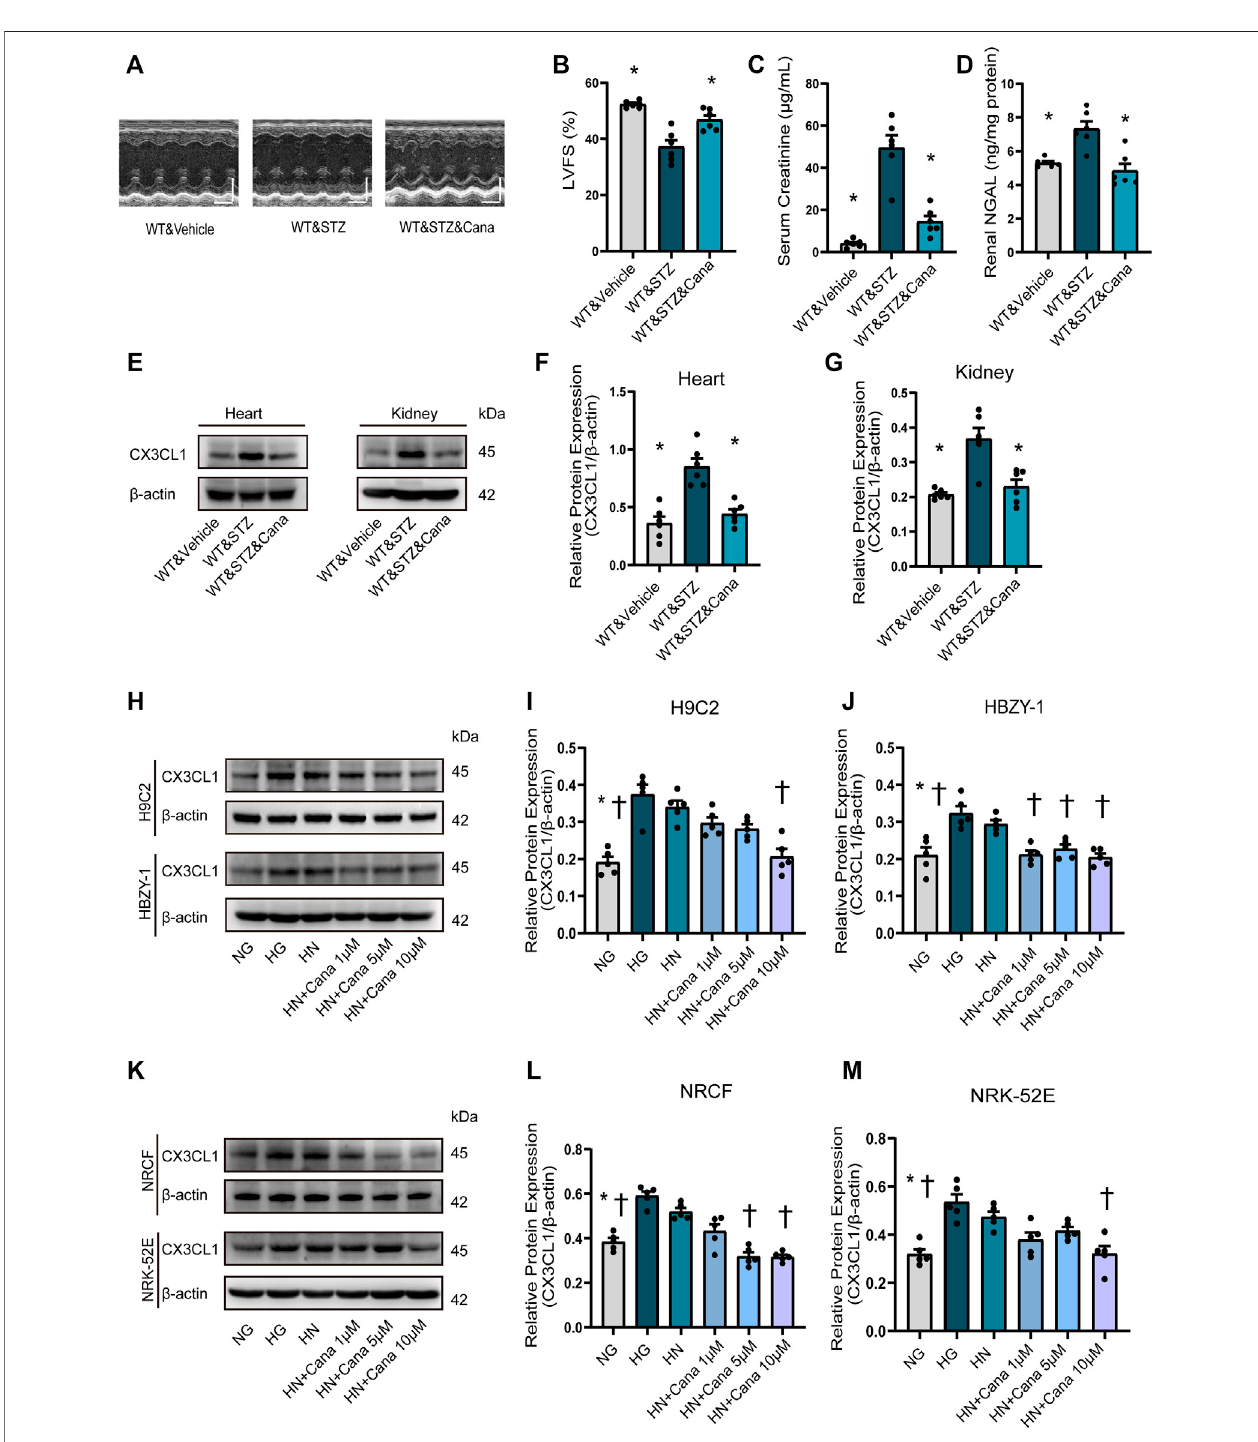
FIGURE 7 | Canagli fl ozin (Cana) improved cardiorenal dysfunction and repressed diabetic induced or high glucose induced CX3CL1 expression. (A) M-mode of echocardiography. Scale bars, 2 mm (upper panels), horizontal bars represent 100 ms. (B) Left ventricular fractional shortening (LVFS). (C) Serum creatinine concentration. (D) Renalneutrophilgelatinase-associatedlipocalin(NGAL)content. (E) CX3CL1expressiondetectedbyWesternblottinginheartandkidneytissues. (F) Semi-quantitation of CX3CL1 expression in heart. (G) Semi-quantitation of CX3CL1 expression in kidney. * p < 0.05 vs . WT&STZ mice; n = 6 per group. (H – M) Western blotting of CX3CL1 levels in cultured cardiomyocytes (H9C2), glomerular mesangial cells (HBZY-1), neonatal rat cardiac fi broblasts (NRCF) and renal tubular epithelial cells (NRK-52E). The cultured cells were exposed for 5 days either to normal concentration of glucose (5 mM, NG) or high concentration of glucose (33.3 mM, HG) as well as to HG for 3 days followed by NG for 2 days (HN) with/without treatment of Cana. * p < 0.05 vs . HG; † p < 0.05 vs . HN; n = 5 per group. Experiments presented in panels (B – D) , (F – G) , (I – J) , and (L – M) were analyzed using one-way ANOVA followed by Bonferroni ’ s post hoc test.